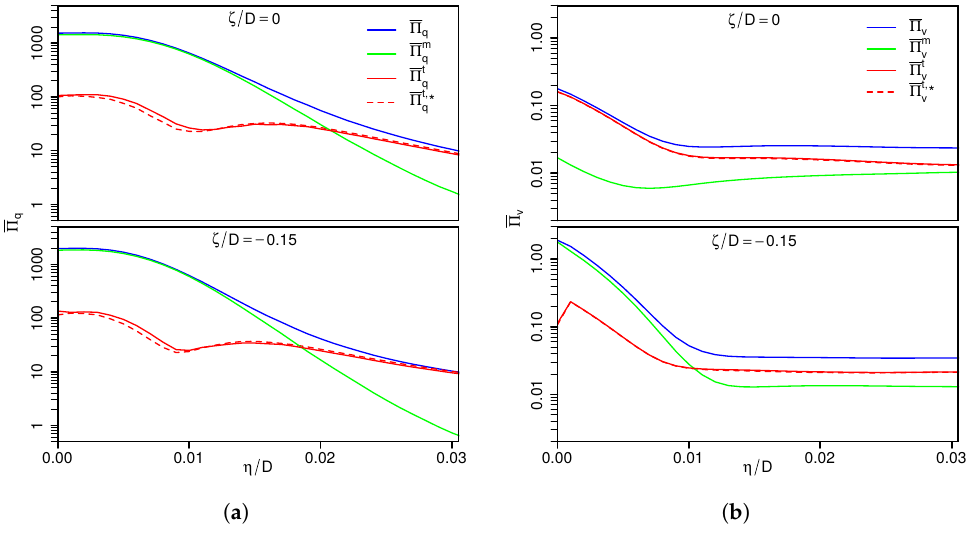
Figure 12. Profiles of mean, turbulent and total entropy production rates due to ( a ) viscous dissipation and ( b ) heat conduction at ζ / D = − 0.15. Dashed lines represent turbulent parts of entropy production rates estimated by means of turbulent dissipation